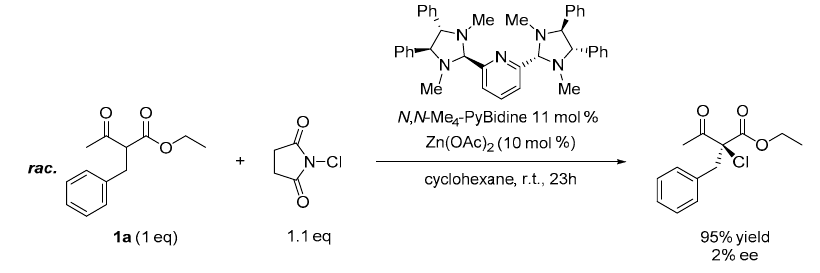
procedure, analytical data, Figure S1: nOe experiment of major epoxide 3 , Figure S2: ESI-MS analysis of a mixture of N -PFB-PyBidine ( L10 )-Zn(OAc) 2 complex, 1a (1 eq) and NaHCO 3 (1 eq) in CH 2 Cl 2 , Figure S3: 1 H-NMR study of L10 -Zn(OAc) 2 complex, 1a (1 eq), NaHCO 3 (1 eq), and CD 3 OD (50 eq) in CDCl 3 .